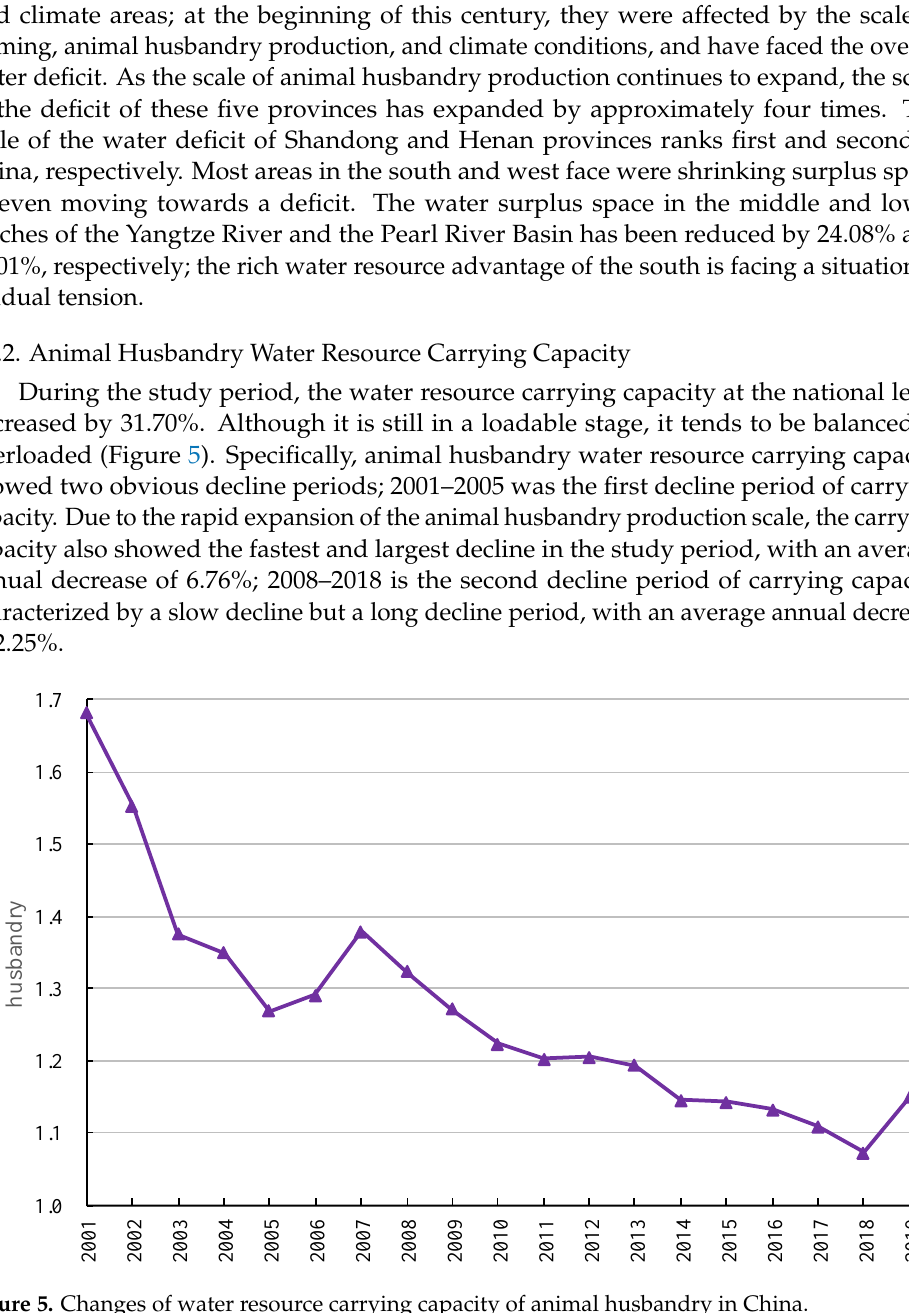
Figure 5. Changes of water resource carrying capacity of animal husbandry in China.